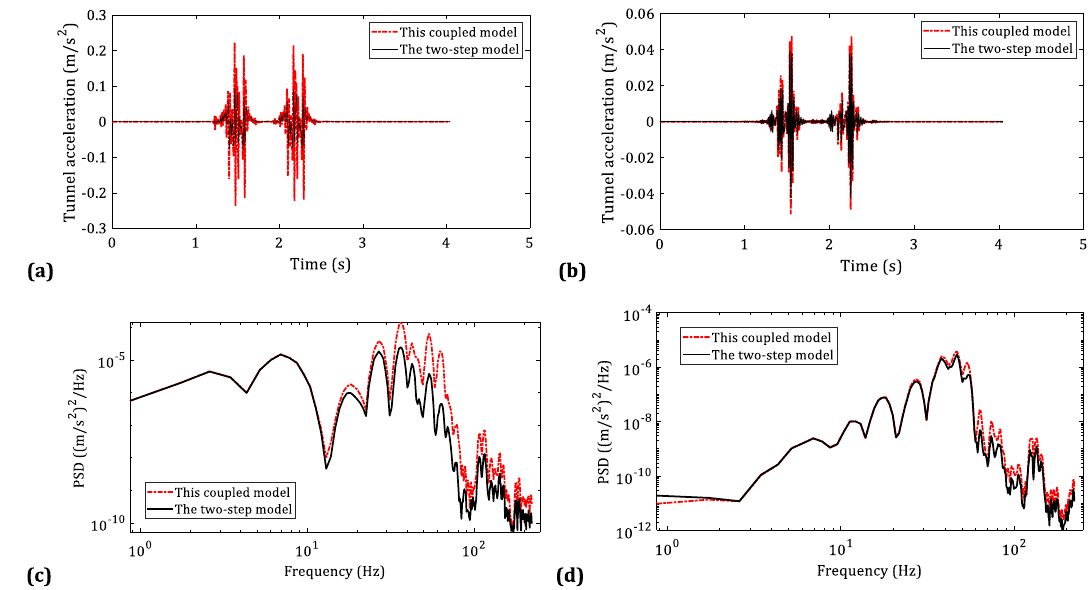
Fig. 24 Comparisons on tunnel acceleration in time and frequency domains: a time-domain vertical acceleration; b time-domain lateral acceleration; c PSD of vertical acceleration; d PSD of lateral